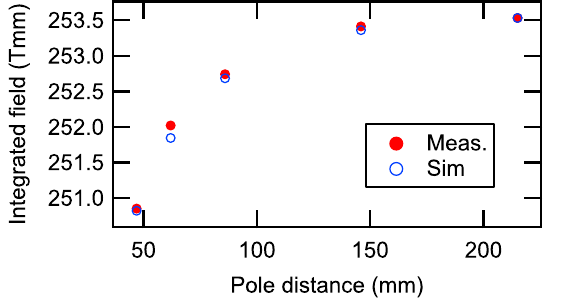
FIG. 5. Integrated field of a DL1 high field dipole and QD2 quadrupole assembly versus pole distance. Red disks (Meas): stretched-wire measurements; blue circles (Sim): simulations. An offset was added to make the measured and simulated field equal at a large distance. The distance errors were estimated to be (cid:2) 1 mm and the repeatability of the measurements was estimated to be (cid:2) 0 . 01% .